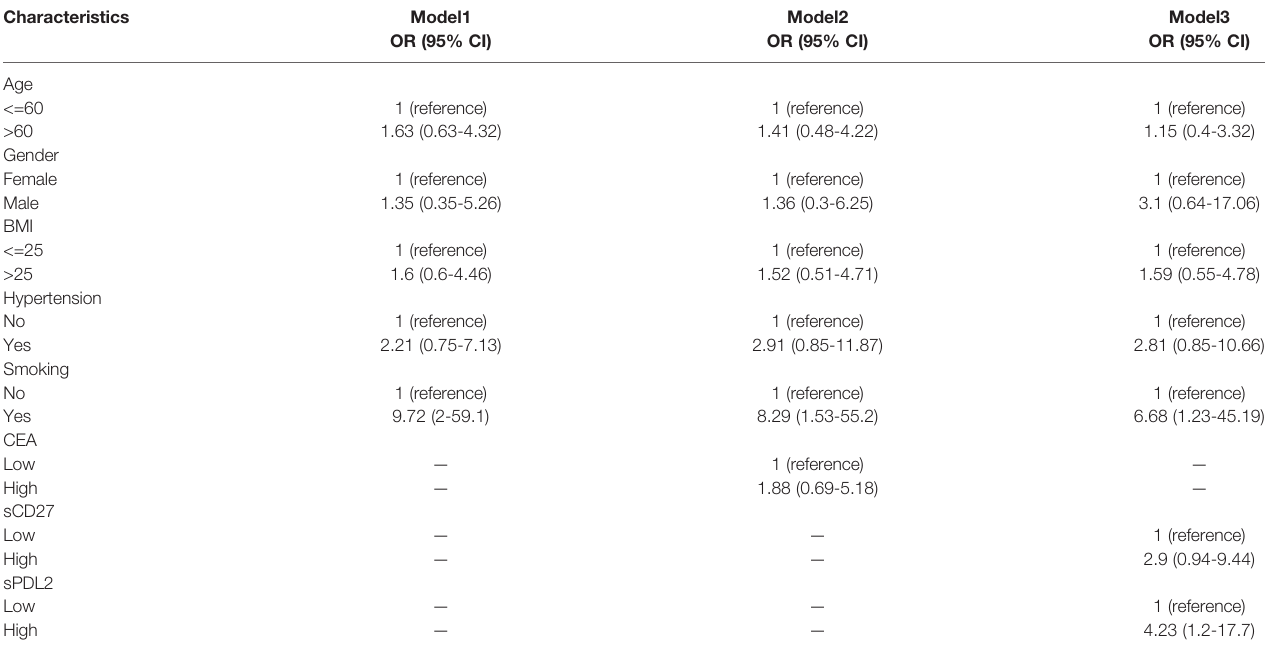
TABLE 2 | Different models of multi-variate logistic regression in prediction of invasive disease.